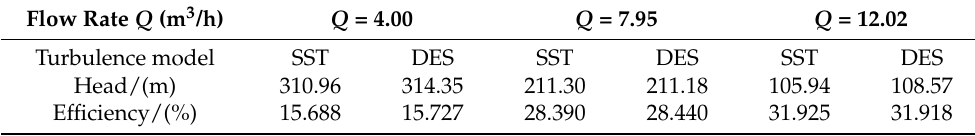
Table 3. Hydraulic performance of the SST and DES models at different flow